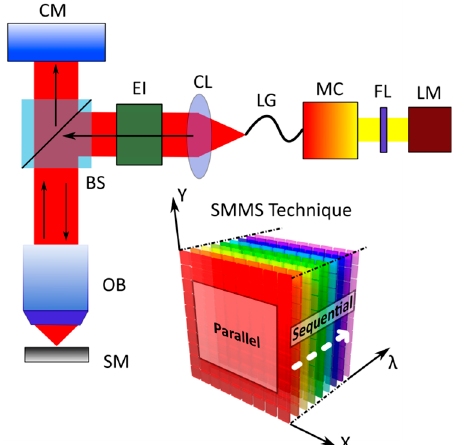
Figure 1. Schematic representation of the SMMS technique in reflection mode configuration. The right bottom inset is a schematic drawing of the SMMS working principle (spectral cube); the measurements are acquired in parallel for the spatial coordinates X and Y , and sequentially along the spectral coordinate λ